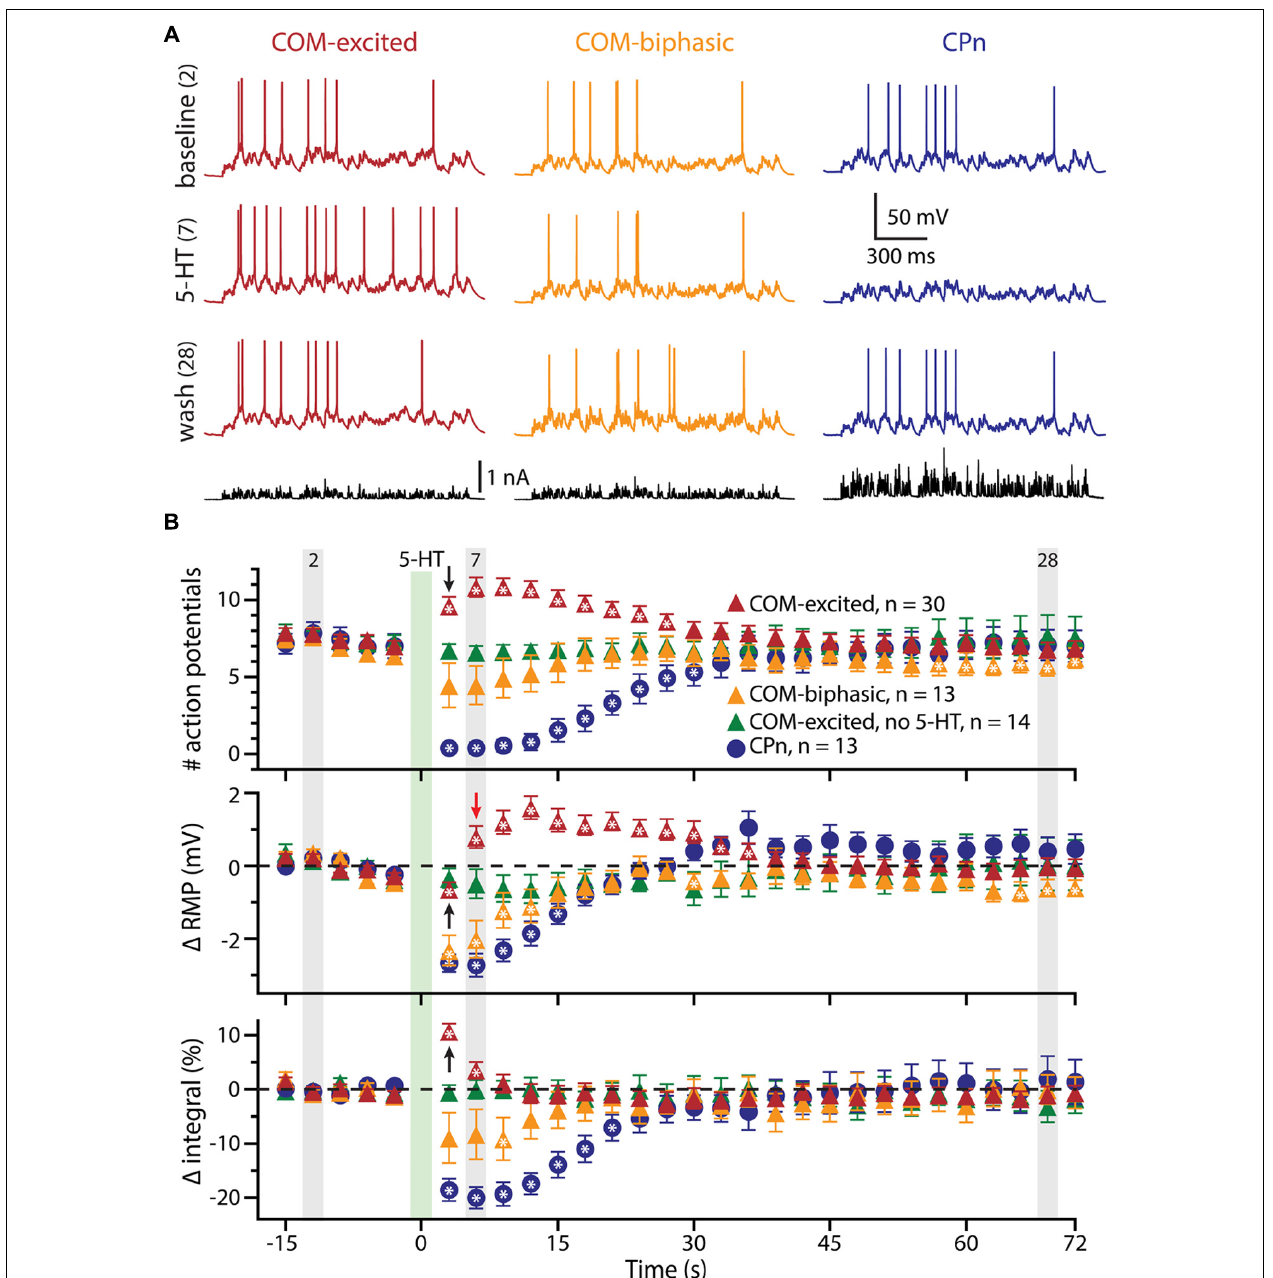
FIGURE 2 | 5-HT modulates neuronal responses to simulated synaptic input. (A) Responses of COM-excited (red), COM-biphasic (orange), and CPn (blue) L5PNs to somatic current injections simulating a barrage of excitatory synaptic input under baseline conditions (top voltage traces), after focal 5-HT application (middle voltage traces), or about one minute after 5-HT application (lower voltage traces). Injected currents (bottom traces) were scaled to generate approximately 7 action potentials (APs) in baseline conditions. (B) Plots of the number of APs generated by simulated synaptic input (top), changes in RMPs (middle), and percent changes in response integrals (bottom), for COM-excited (red), COM-biphasic (orange), and CPn (blue)